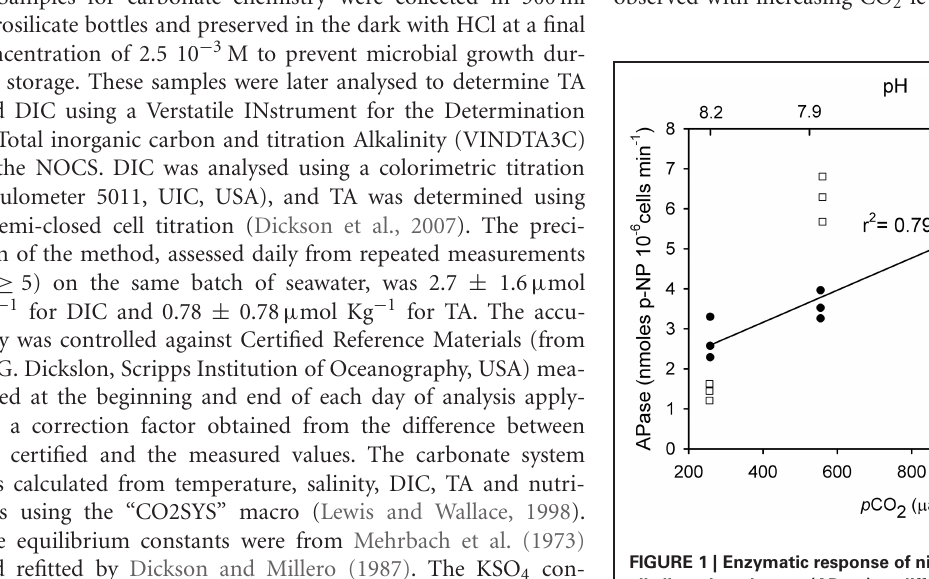
FIGURE 1 | Enzymatic response of nitrate reductase (NRase) and alkaline phosphatase (APase) to different CO 2 and nutrient scenarios in Emiliania huxleyi